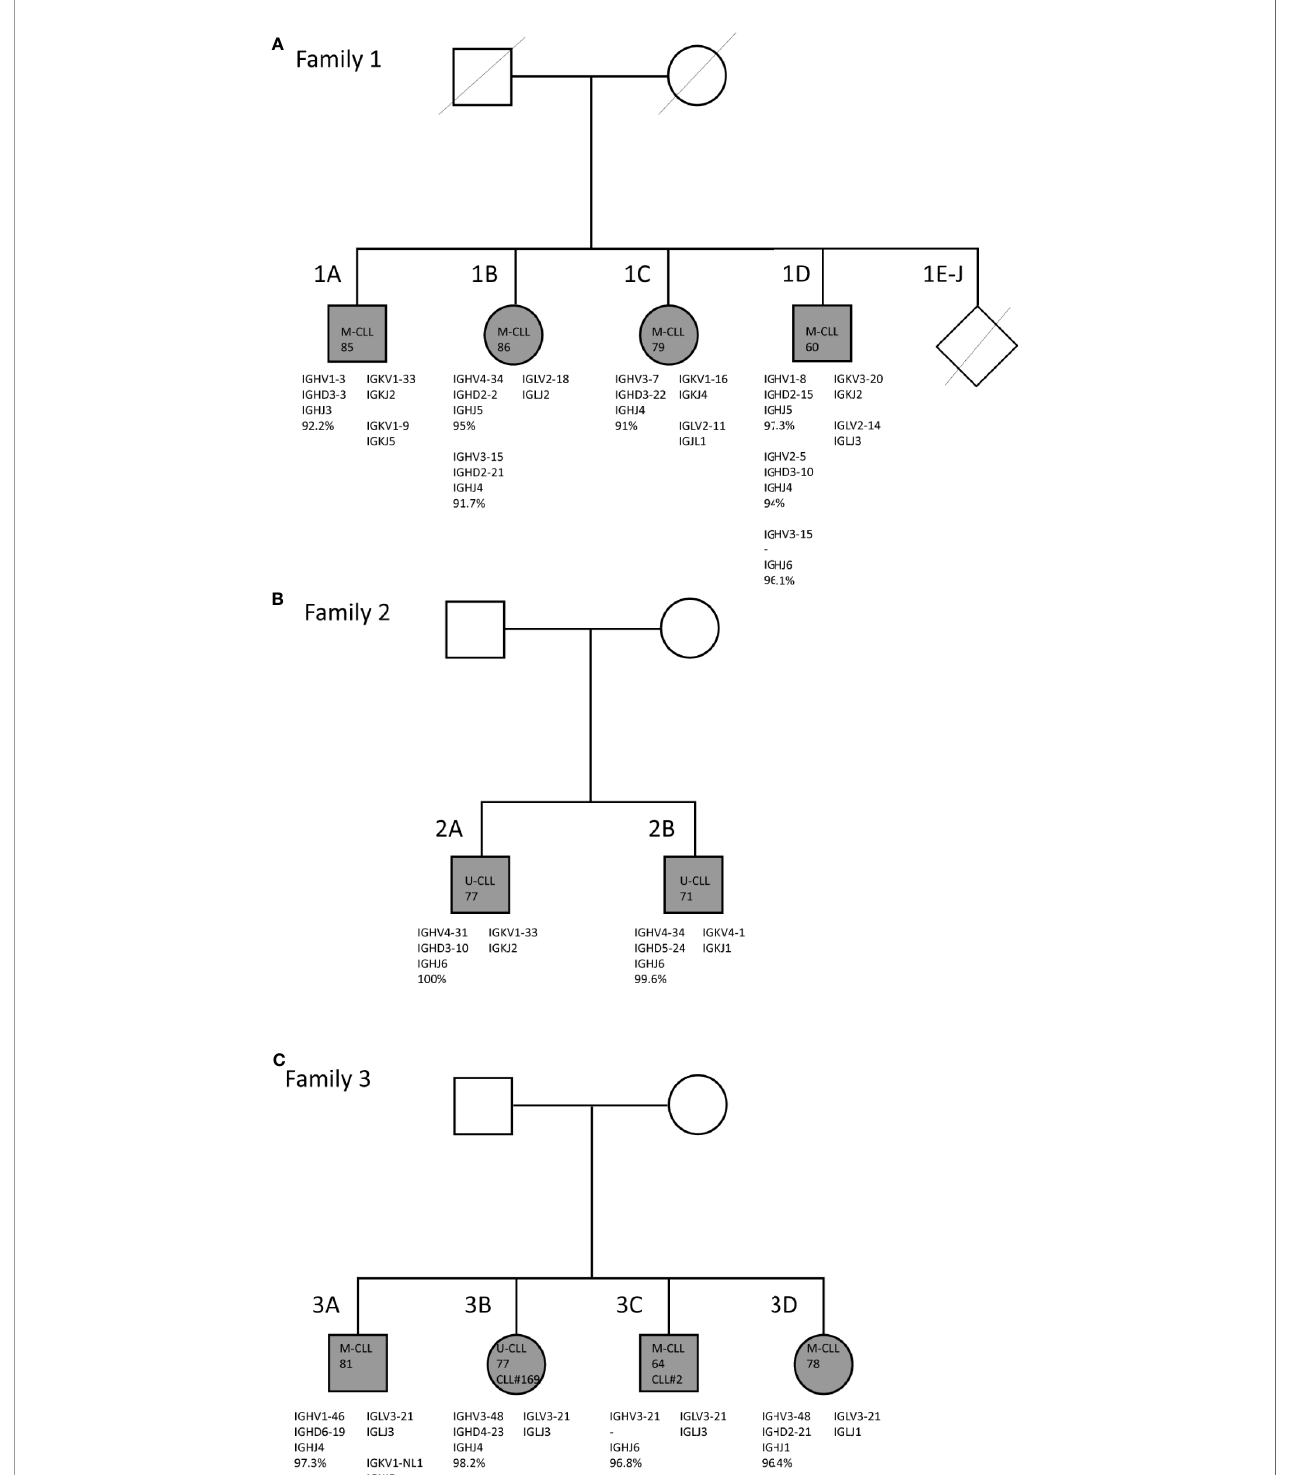
FIGURE 1 | Family trees and BcR IG characteristics of familial CLL cases. (A) Family 1 consists of two brothers and two sisters who carry mutated IGHV genes. (B) Family 2 consists of two brothers who both carry unmutated IGHV genes. (C) Family 3 consists of two brothers and two sisters. In all four siblings, the CLL clone utilizes the IGLV3-21*04 gene with the characteristic R110 mutation and the K16 and YDSD motifs. Additionally, siblings 3B and 3C express similar IGHV genes, i.e. IGHV3-21 and IGHV3-48, and belong to stereotyped subsets #2 and #169,